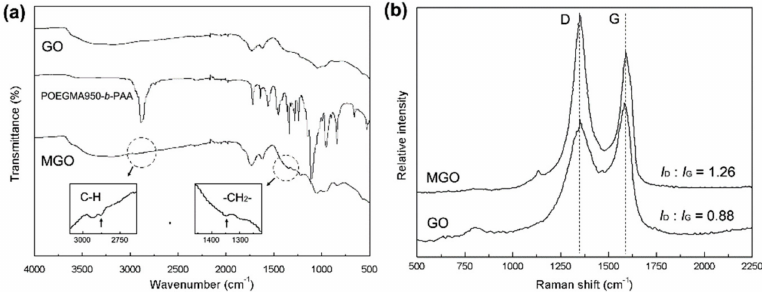
Figure 2. ( a ) Fourier transform infrared spectroscopy (FTIR) spectra and ( b ) Raman spectra of